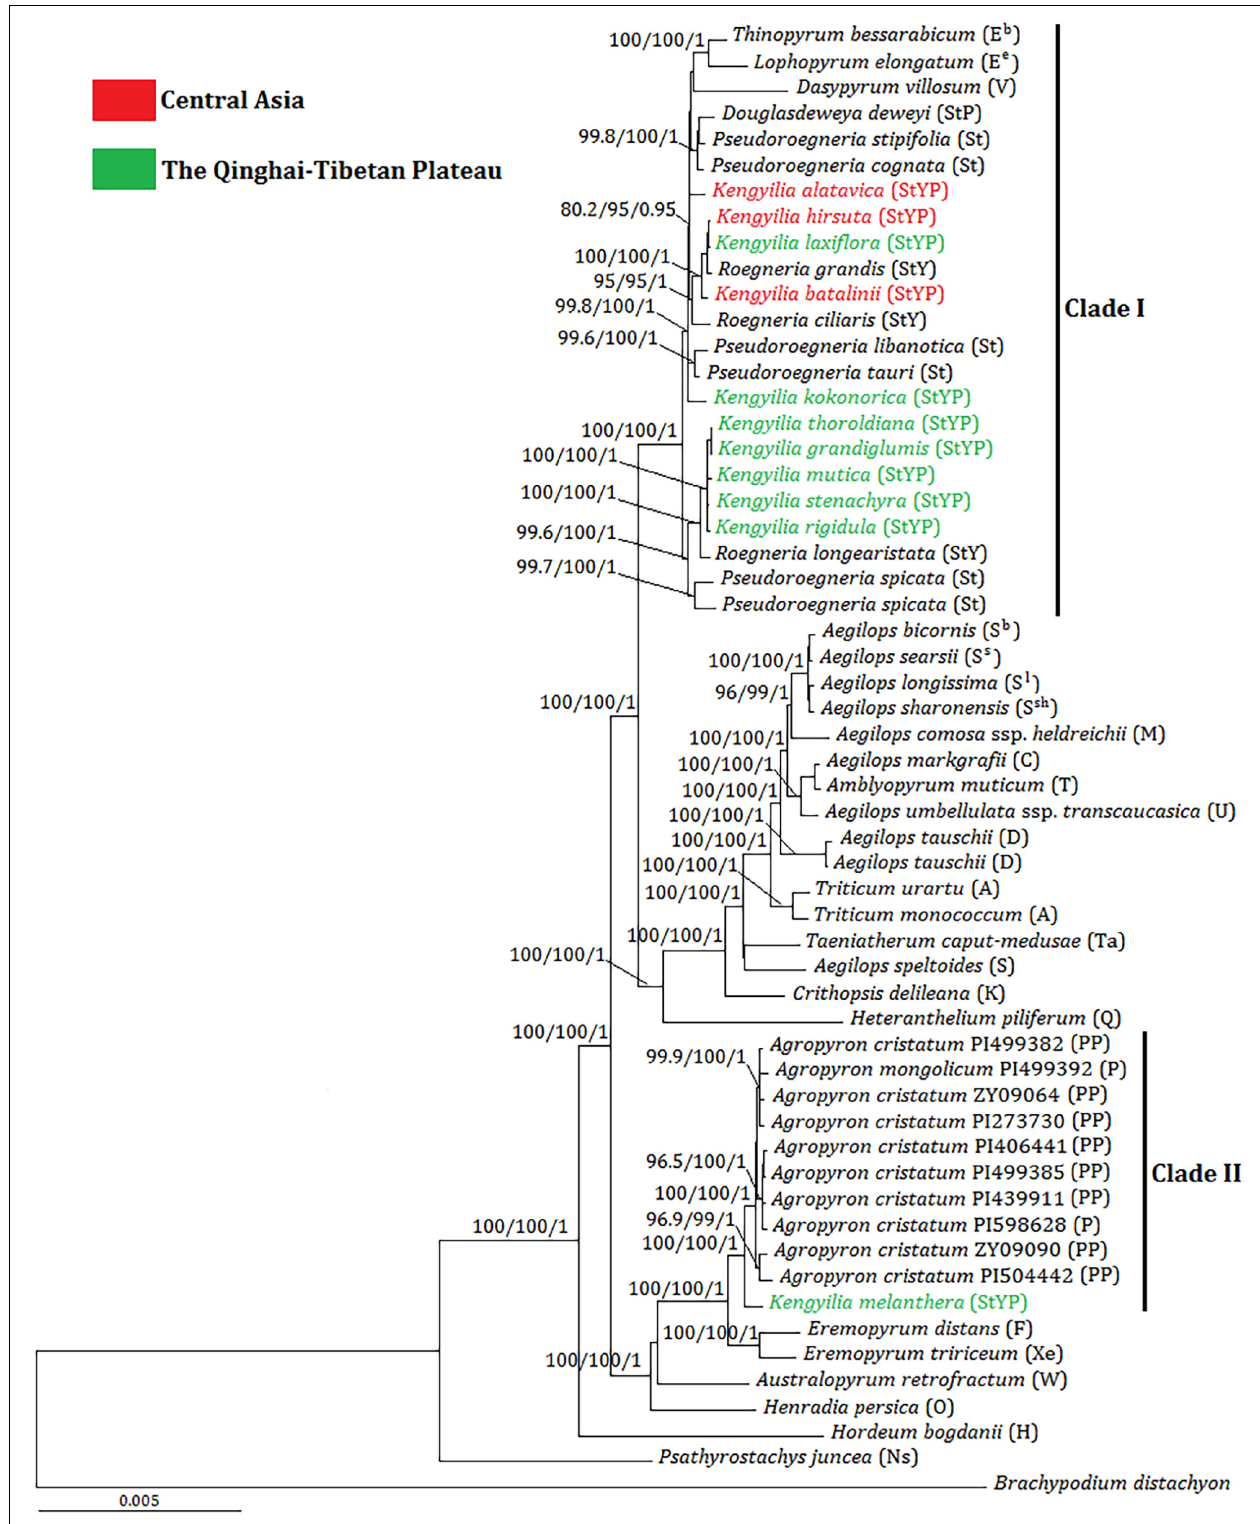
FIGURE 2 | Bayesian tree inferred from the complete chloroplast genome sequences for Kengyilia species and its diploid relatives in the Triticeae. Numbers above branches are values of the statistical support values, and values are indicated only if deemed robust as follows: UFboot ≥ 95%/SH-aLRT ≥ 80%/PP ≥ 0.9. The capital letters in brackets indicate the genome type of the species. Different colors indicated the geographic information of Kengyilia species.